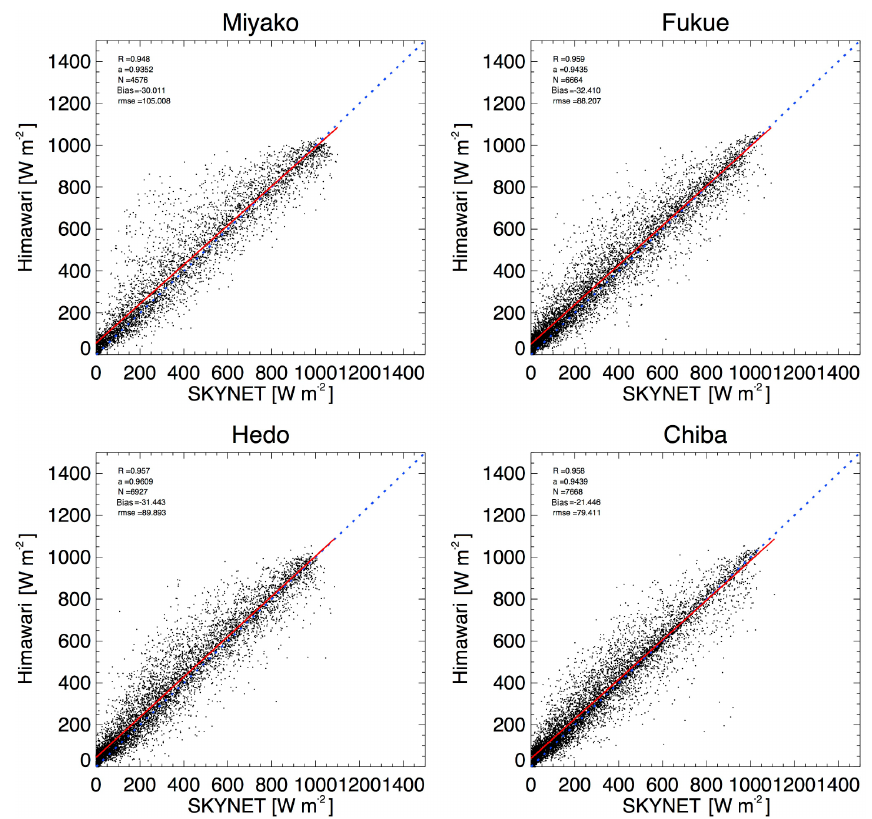
Figure 2. Scatter plot of ground-based SKYNET observations and satellite-based estimates of surface global irradiance from Himawari-8 at the Chiba, Fukue, Miyako, and Cape Hedo stations in 2016. Statistics describing the comparison, i.e., correlation coefficient ( r ), slope of the regression line ( a ), number of samples ( N ), mean bias (bias), and root mean square error (RMSE), are shown in the upper left corner; the dashed line is a 1:1 line, and the regression line is shown in red. Time step: